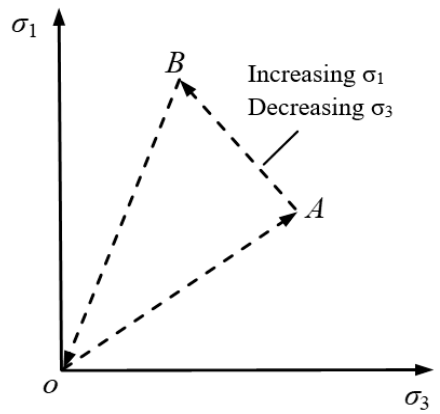
Figure 3. Specimen loading path.